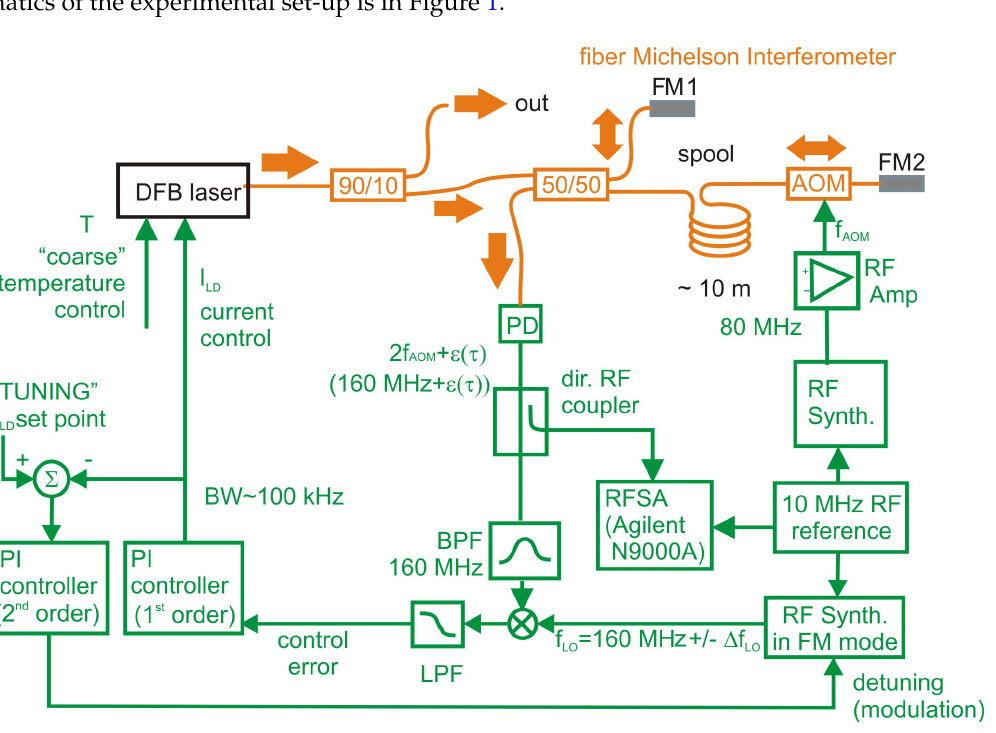
Figure 1. Schematics of the set-up of noise suppression of Distributed FeedBack (DFB) laser diode. 90/10 and 50/50 are fiber splitters, FM1 and FM2 are Faraday mirrors, AOM—acusto-optic